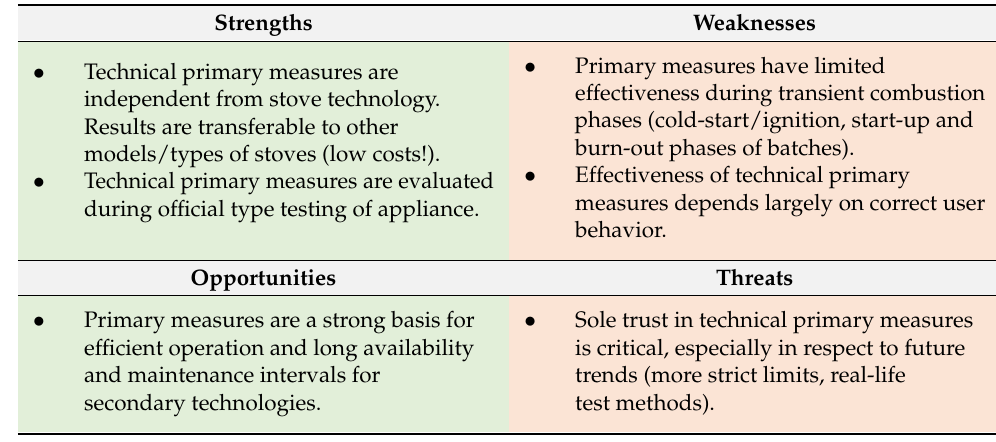
Table 7. SWOT analysis of technical primary measures: air supply and air staging concept, combus- tion chamber design, draught control and automatic combustion air regulation devices.